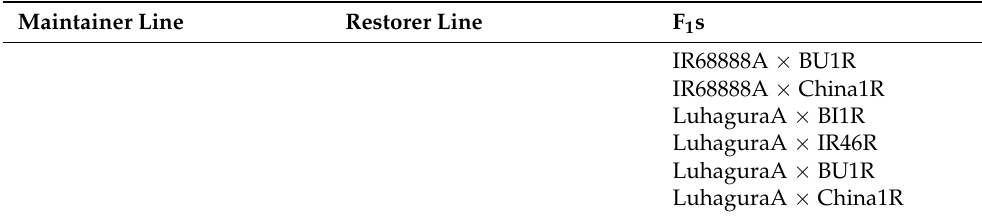
Table 1. Cont. Maintainer